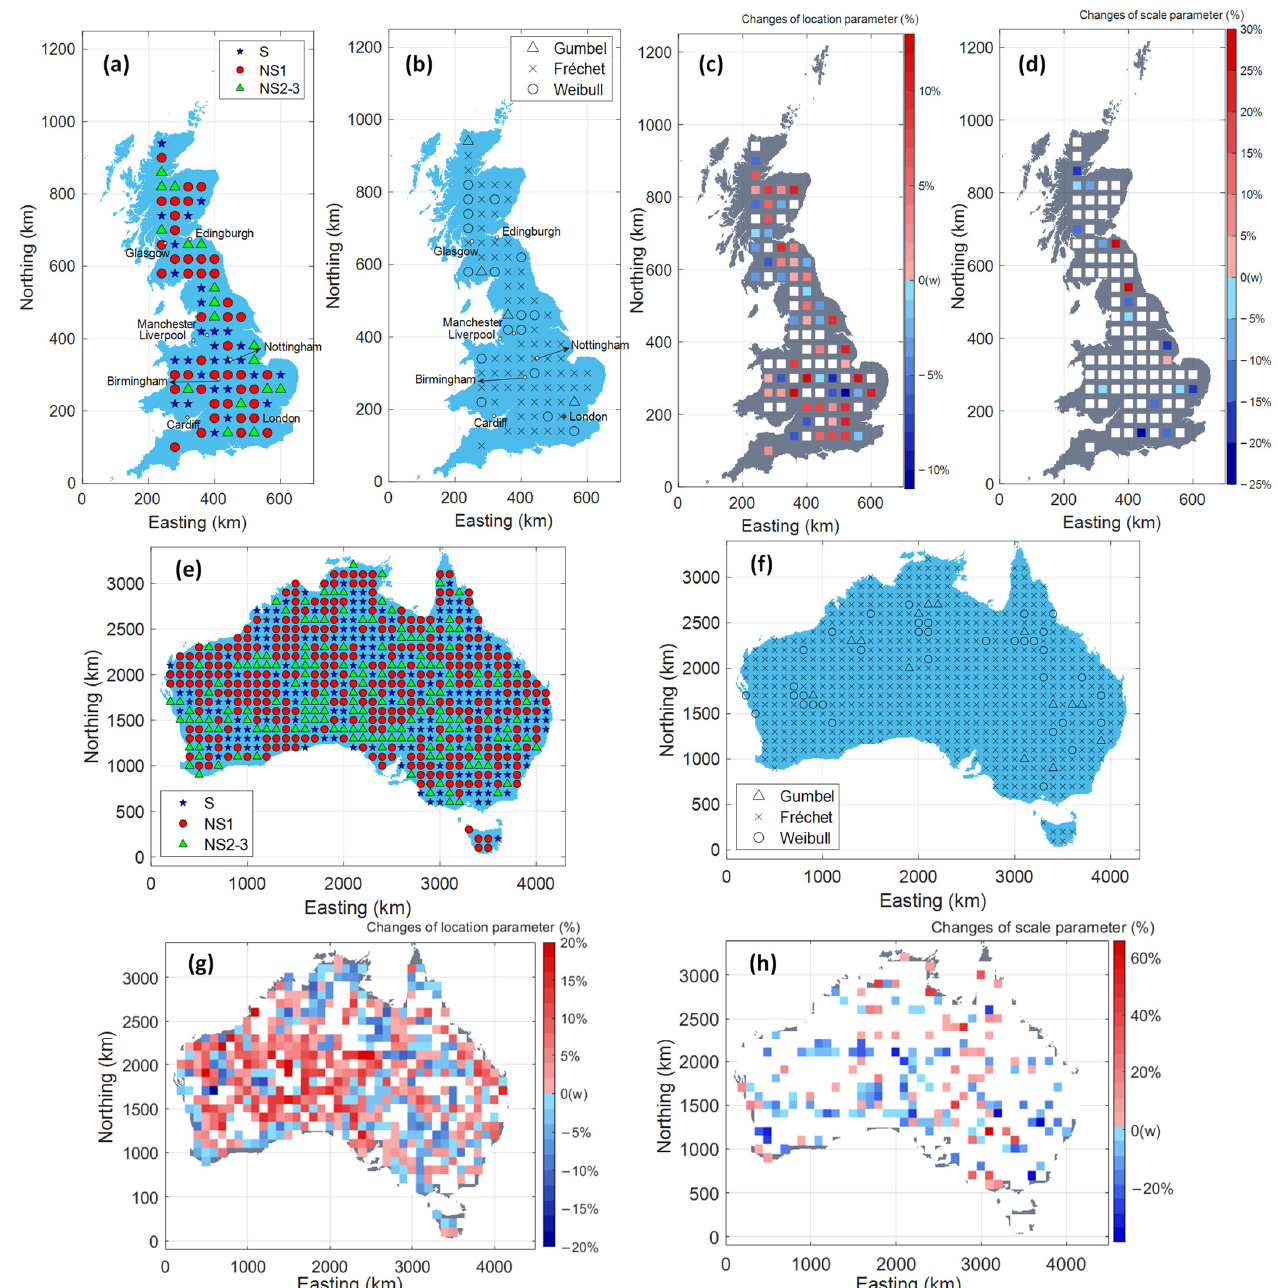
Figure 4. Spatial distribution of ROIs with the size of 500 km 2 and relative rounded shape in terms of (1) the best-selected model type in GB ( a ) and AU ( e ); (2) the best-fitted GEV type in GB ( b ) and AU ( d ); (3) the changes of location ( c , g ) and scale parameters ( d , h ) in percentage within the record periods (113 years for GB and 129 years for AU) and please noted that white colour (“w” specified in the colour bar) indicates the ROI with no change in the parameters.